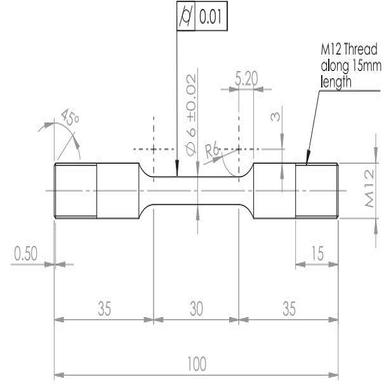
RB6 specimen geometry.